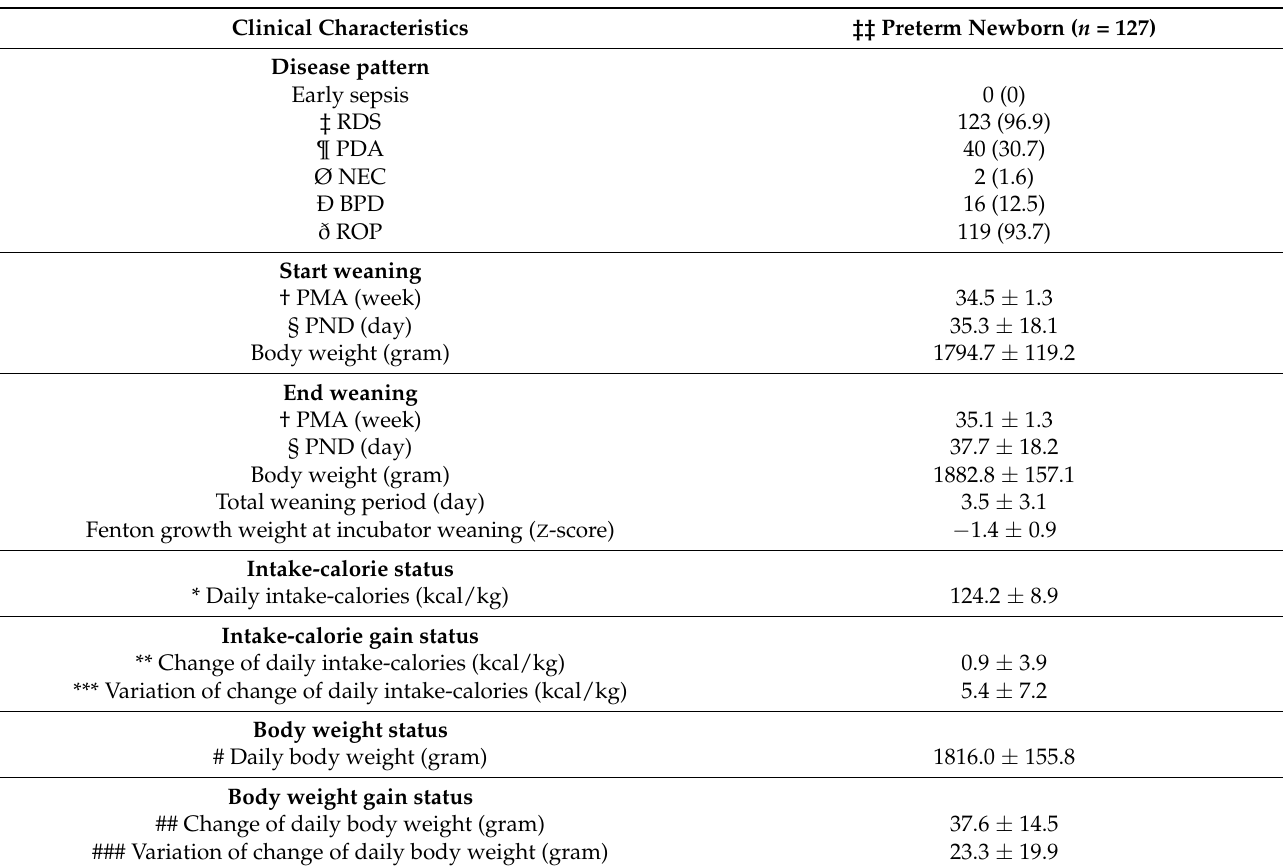
Table 2. Clinical characteristics of preterm newborns enrolled in the NICU of Kaohsiung Medical University